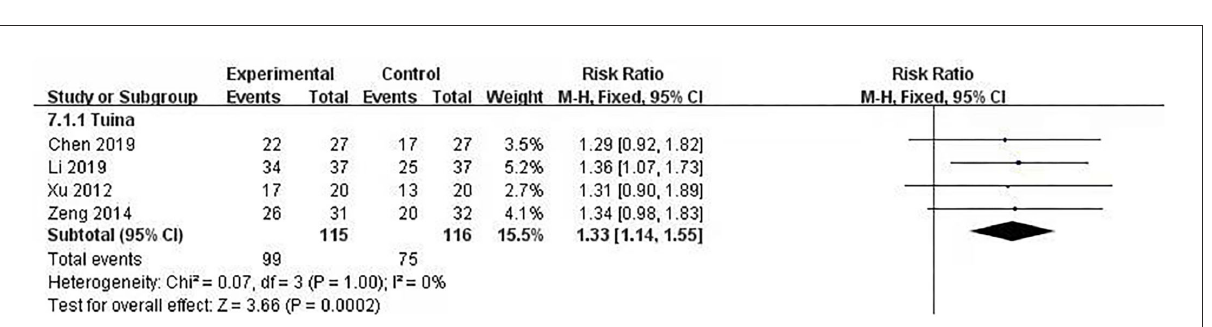
FIGURE4 Comparison 1: therapeutic massage vs. control. Outcome 1: Total